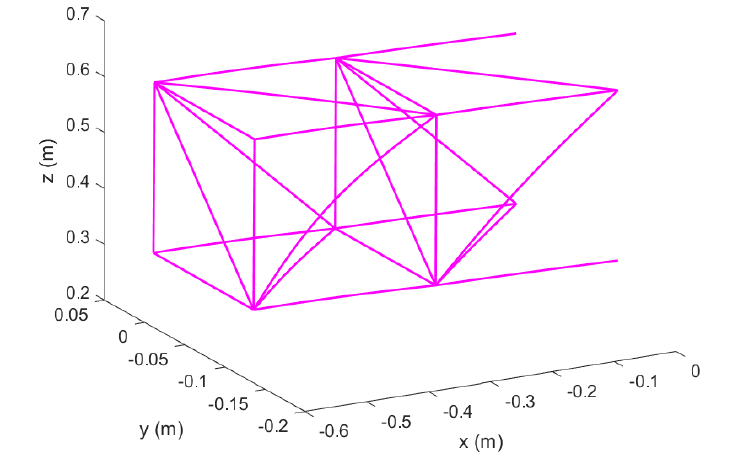
Figure 33. Mode 1 of Timoshenko beams in Topology 1 with hinged ends; spanwise expanded configuration.